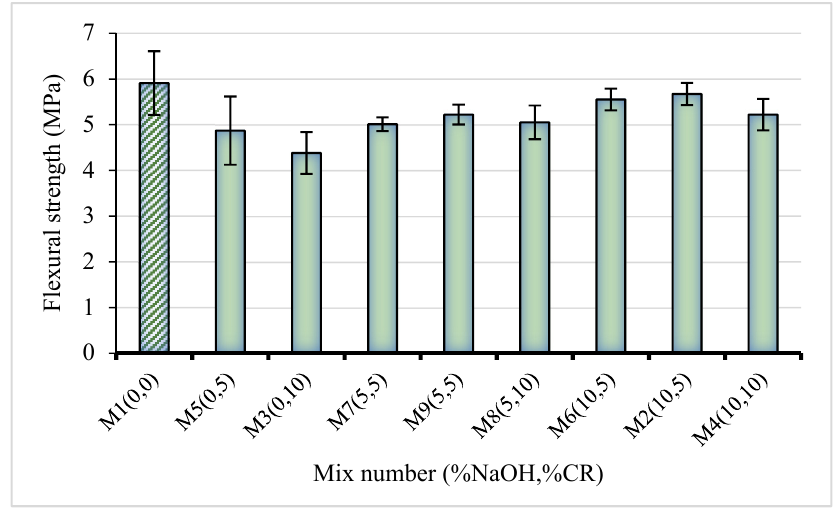
Figure 7. Flexural strength of NaOH-CRC mixes at 28 days.